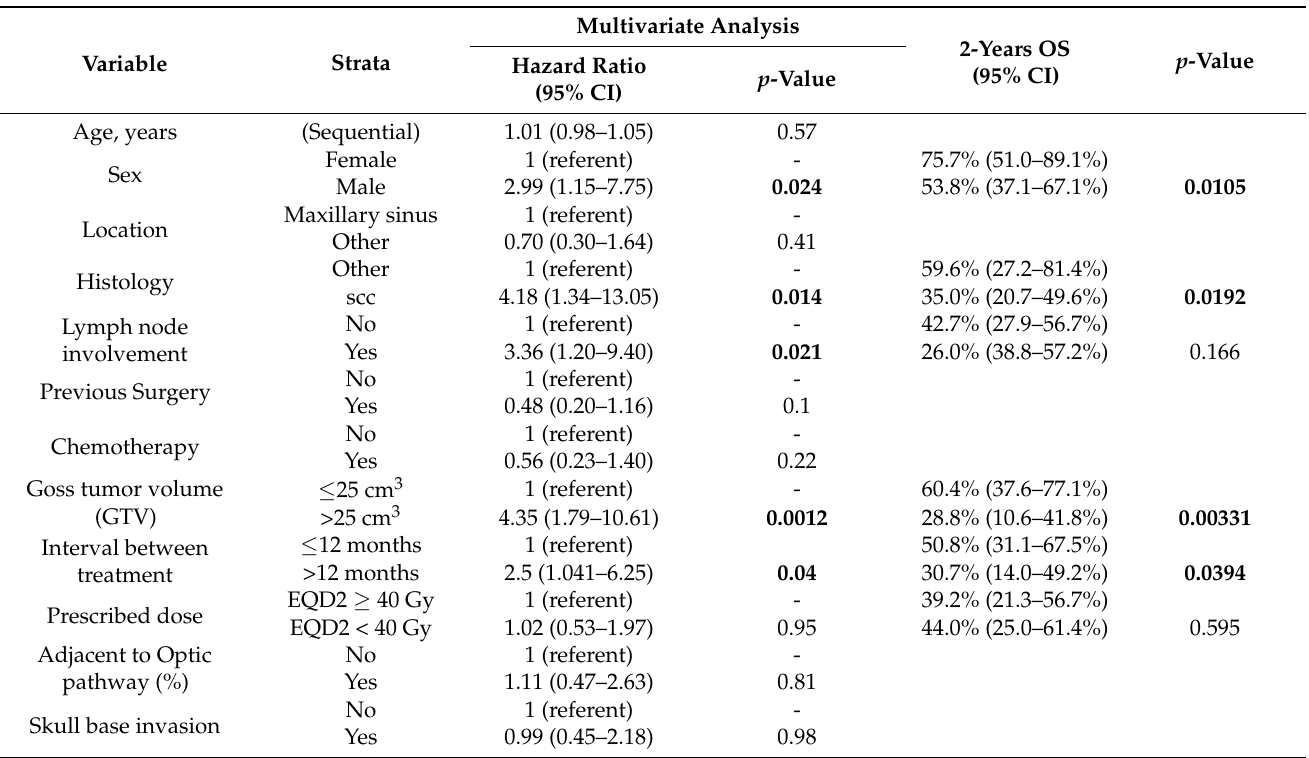
Table 2. Multi-variate analysis for survival rate using Cox proportional hazards model.